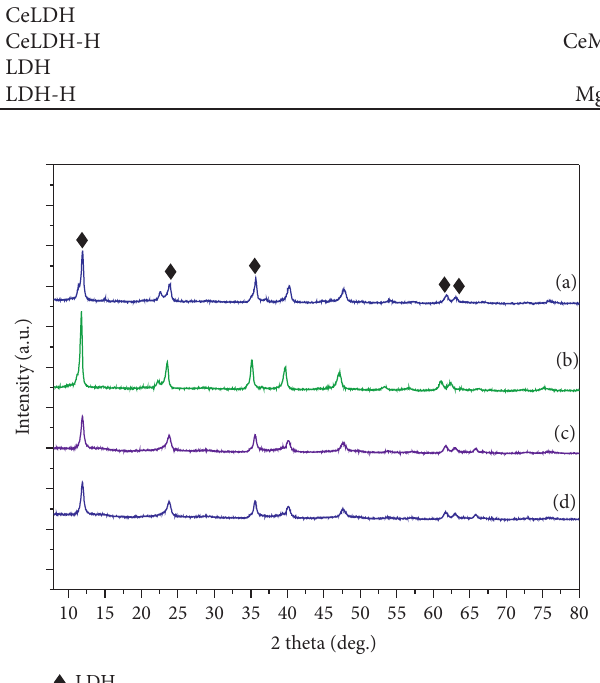
Figure 2: XRD spectra of LDHs films deposited on AA6082, (a) CeLDH, (b) LDH, (c) CeLDH-H, (d)